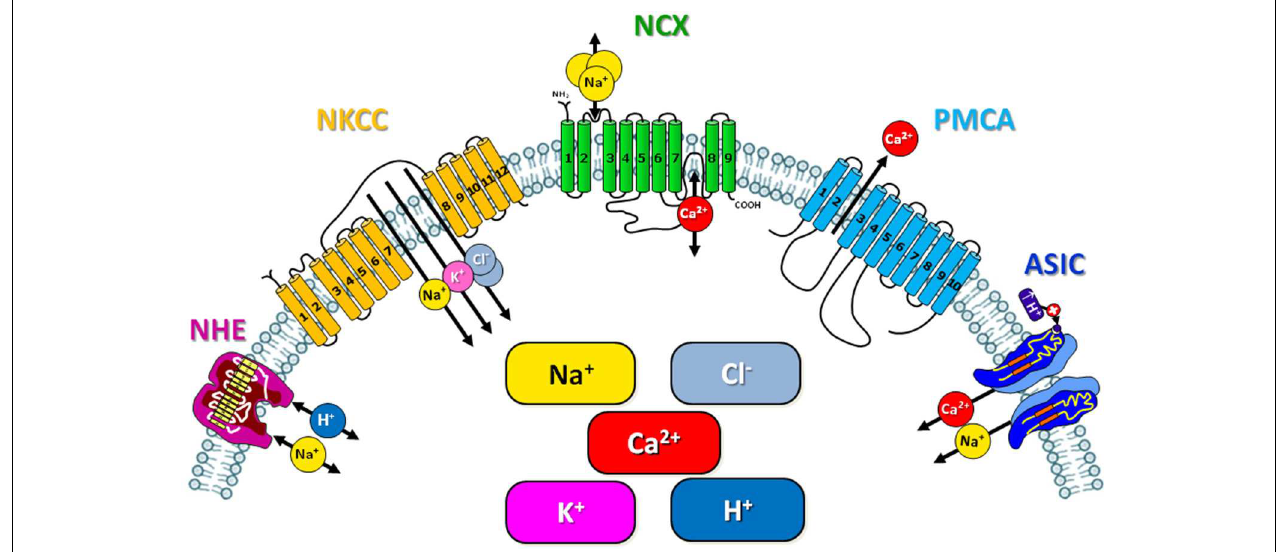
FIGURE 1 | Schematic representation of the ionic exchangers/transporters involved in the neuroprotection mediated by ischemic preconditioning and post-conditioning.